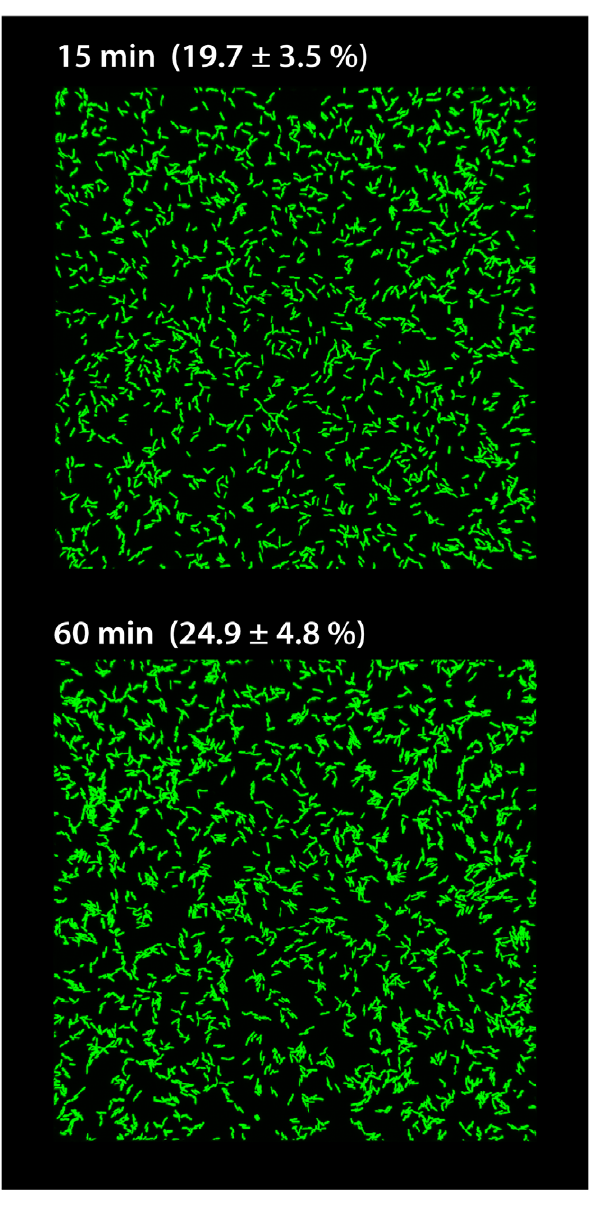
Figure 1. Coverage of a glass surface after inoculation and medium flow for 15 (upper image) and 60 minutes (lower image). Displayed are images taken by confocal laser scanning microscopy in flow chambers at the indicated time points. The lateral edge of each image equals 250 m m. The values given represent the average and standard deviation of surface coverage in percent of 6 randomly selected spots in three different channels of a flow chamber.